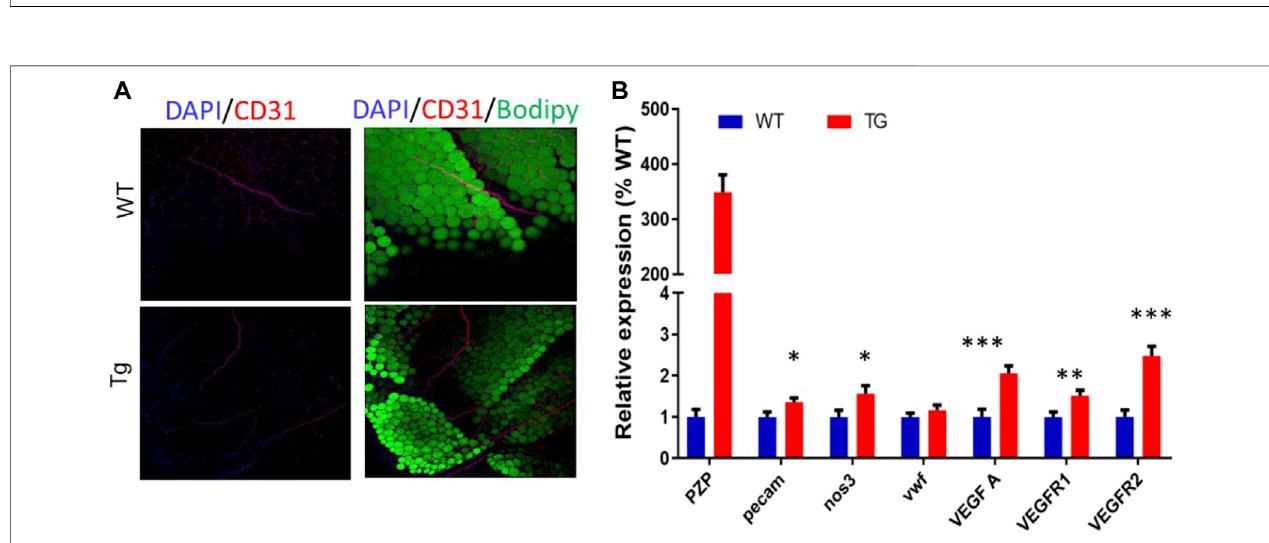
FIGURE 5 | PZP TG promotes angiopoiesis in epididymis adipose tissue. (A) Whole-mount tissue staining images of vWAT from WT and PZP TG mice using anti- CD31. (B) Relative mRNA expression of angiopoiesis-related genes in EP from WT and PZP TG mice ( n = 7).